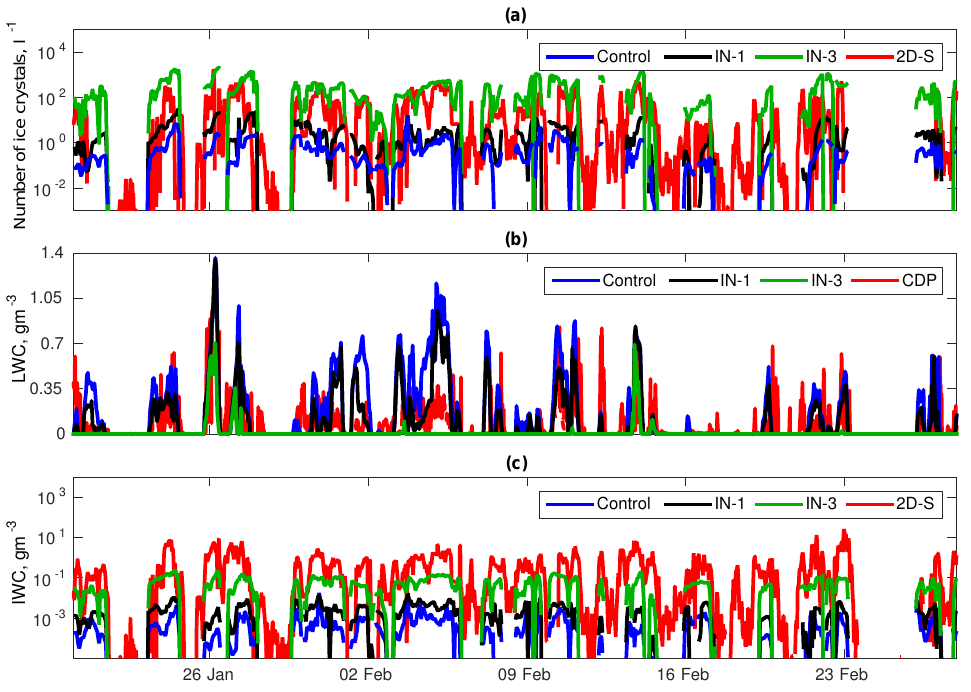
Figure 6. (a) Comparison of 2D-S ice number concentration measured at Jungfraujoch during the INUPIAQ campaign with the ice number concentration from the control, IN-1 and IN-3 WRF model simulations. (b) Comparison of the CDP LWC measured at Jungfraujoch during the INUPIAQ campaign with the LWC from the control, IN-1 and IN-3 WRF model simulations. (c) Comparison of IWC inferred from 2D-S measurements at Jungfraujoch during the INUPIAQ campaign with the IWC from the control, IN-1 and IN-3 WRF model simulations.